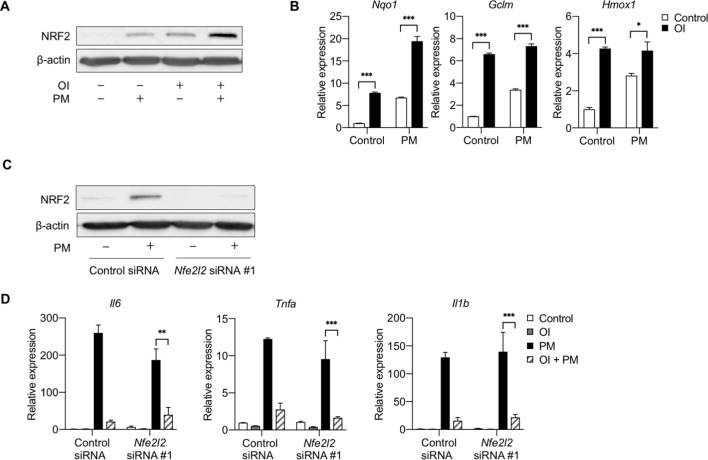
NRF2 is not required for the anti-inflammatory effects of exogenous itaconate (OI) on PM-induced inflammatory response.(A) Western blot showing upregulation of NRF2 protein following 2 hours of OI pretreatment (0.25 mM) followed by 4 hours of PM (20 µg/cm2) treatment. The combination of OI and PM further increased NRF2 activation. (B) qPCR of NRF2 target genes (Nqo1, Gclm, and Hmox1) in WT BMDMs treated with PM for 4 hours, with or without OI pretreatment (0.25 mM, for 2 hours). (C) BMDMs transfected with scramble control siRNA or Nfe2l2 siRNA (#1), Western blot analysis of control siRNA and Nfe2l2 siRNA (#1)-transfected BMDMs following 4 hours of PM treatment to induce NRF2 protein. (D) qPCR of pro-inflammatory cytokine genes (Tnfa, Il6 and Il1b) in Nfe2l2 siRNA-transfected BMDMs treated with OI (2 hours of pretreatment) and PM (4 hours). Significance of qPCR was analyzed with one-way ANOVA corrected with Bonferroni’s post hoc test for multiple comparisons, *p<0.05, **p<0.01, ***p<0.001.